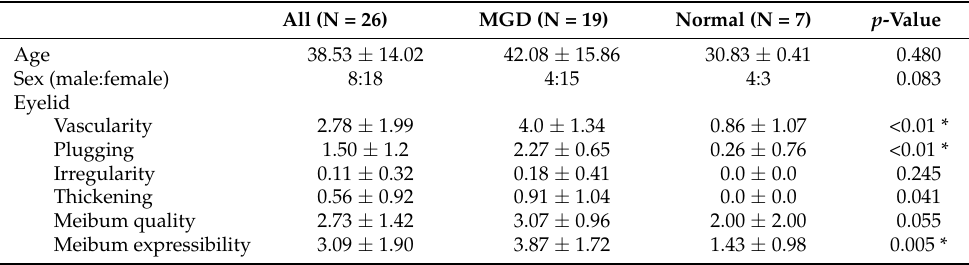
Table 1. Demographics and clinical characteristics of the participants.